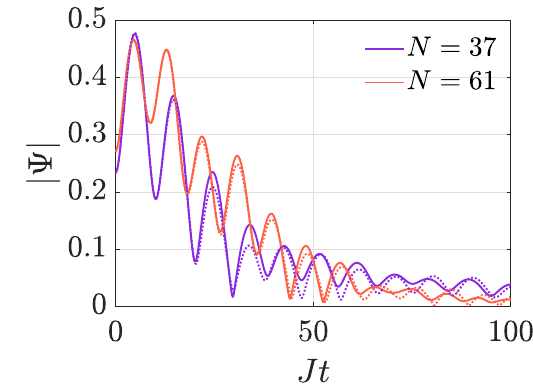
FIG. 6. Benchmarking the DTWA method. Solid lines are computed by numerical propagation of the Schrödinger equation, while the dotted lines are obtained using the DTWA method. Here, we assume that the crystal is made of perfectly concentric rings of ions and that the spin state is initialized in a BCS- like state [top panel of Fig. 2(a)]. Here, we have used the ratio K / J = 1.